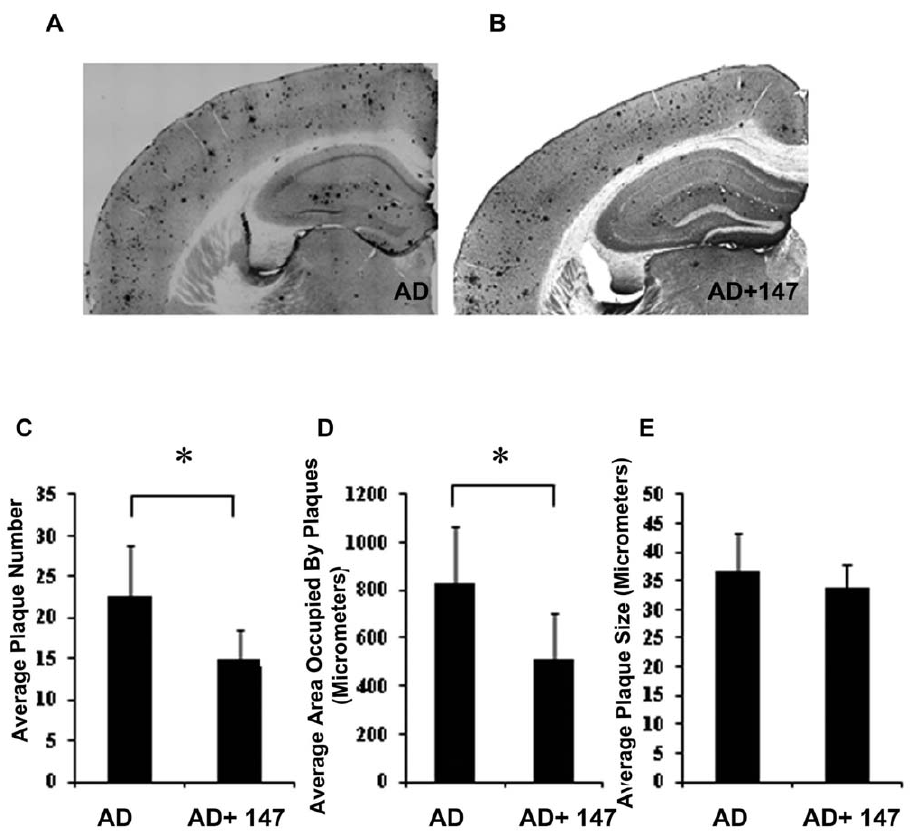
Figure 6. Immunohistochemical analysis of condensed A b deposits. Immunohistochemical analysis was done using brain coronal sections of 13-month old AD mice on control diet (A) or J147 diet (B) using antibody 6E10. In comparison to AD control mice (A), condensed A b deposits were significantly reduced in the hippocampus region of AD mice on J147 diet (B). 30 micron thick sections of similar regions from each mouse, (n=6) were examined and plaque counts in the hippocampus were quantified. All images were quantified using Image J Software. (C) The average of plaque counts for each mouse group is expressed as a number of plaques 6 the SD (n=6 per group: unpaired t-test, *P , 0.05). (D) Reduced A b plaque load in AD mice on J147 diet. The A b plaque load was determined by measuring the area occupied by A b -immunoreactive condensed deposits, (n=6 per group: unpaired t-test, *P , 0.05). (E) The plaque size did not change between AD mice on control and J147 diets (n=6 per group: unpaired t-test, *P .